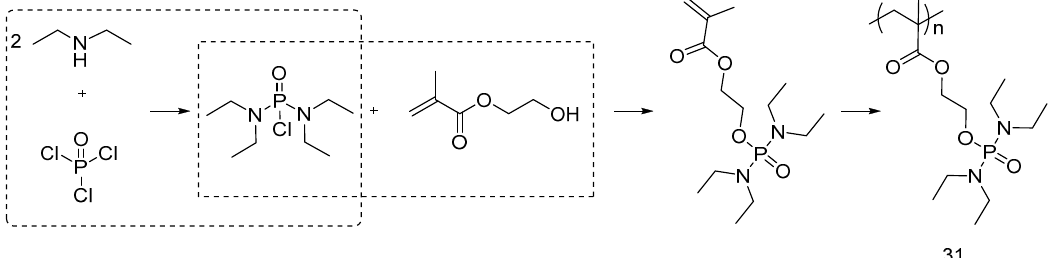
Figure 22. Representative synthesis of methacryloyloxyethylorthophosphorotetraethyl-diamidate polymer.